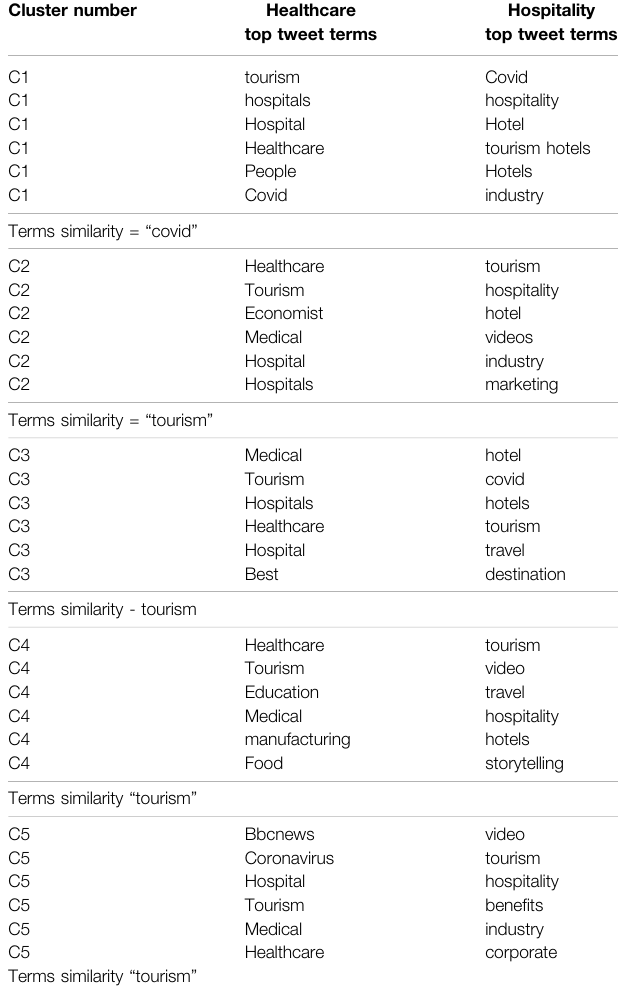
TABLE 3 | Similar terms and inter cluster